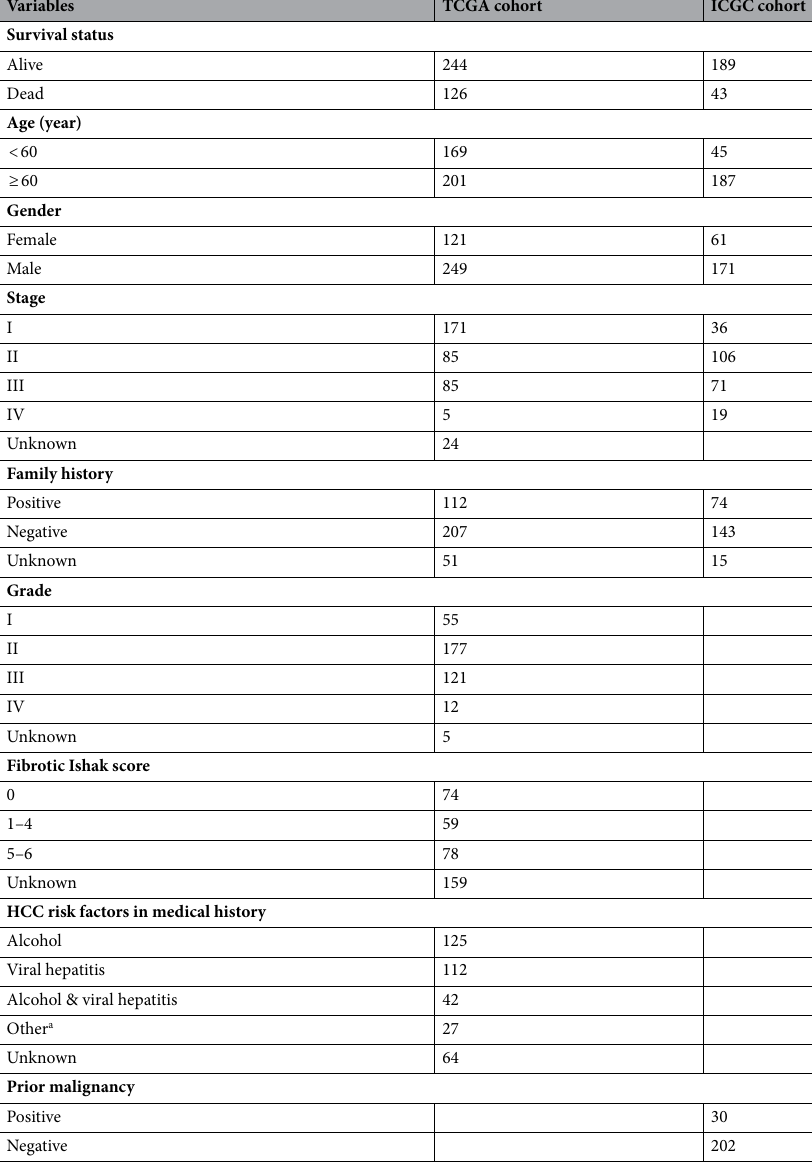
Table 1. Clinicopathological features of HCC patients in this study. a Other risk factors include Gibert’s syndrome, hemochromatosis, medicine and so